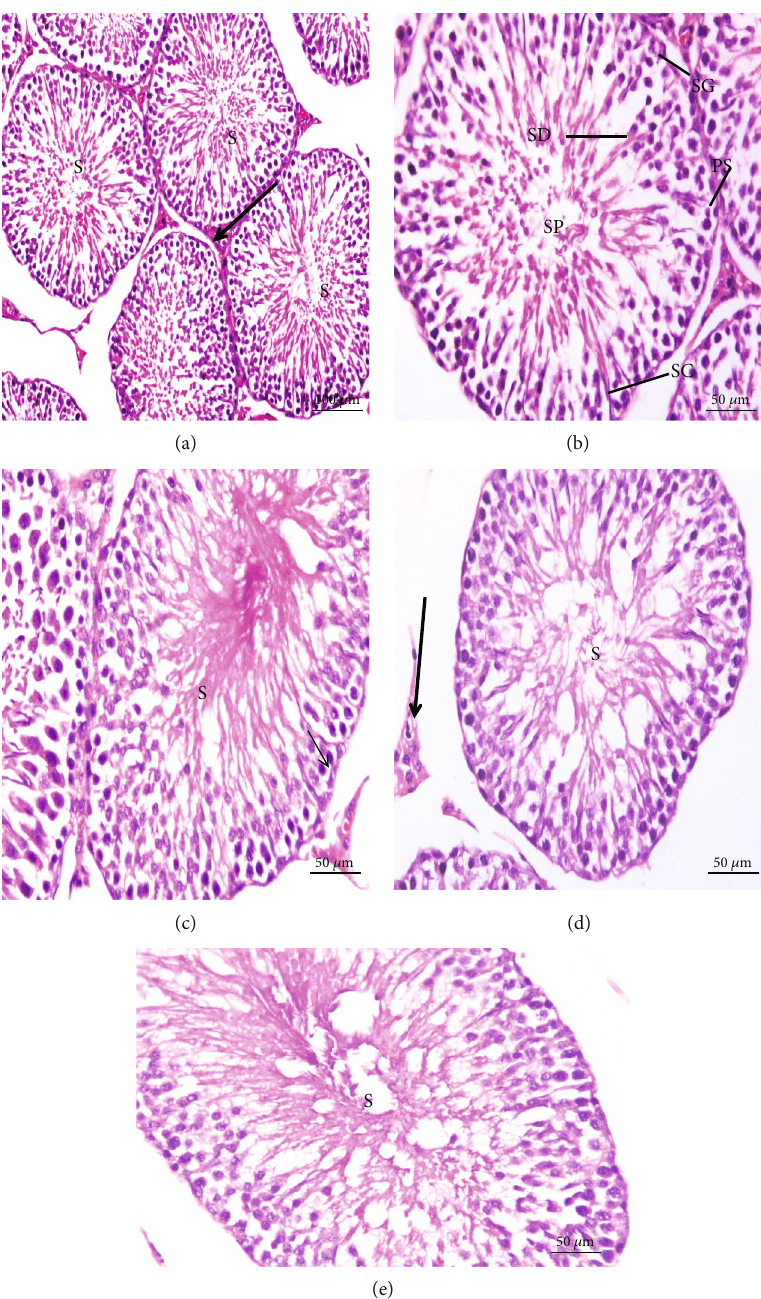
Figure 8: Photomicrographs of sections in testis of control rat groups: (a) water; (b) magni fi ed cross section of (a); (c) CMC; (d) curcumin; (e) stem cells showing normal histological structure seminiferous tubules (S), interstitial space containing Leydig cells (arrow), spermatogonia (SG) resting upon the basal lamina of the seminiferous tubules that are oval in shape, primary spermatocytes (PS), recognized by their large nuclei, spermatids (SD) with rounded nuclei, Sertoli cells (SC) with nuclei located basally, and sperms in the lumen of the tubules (SP)